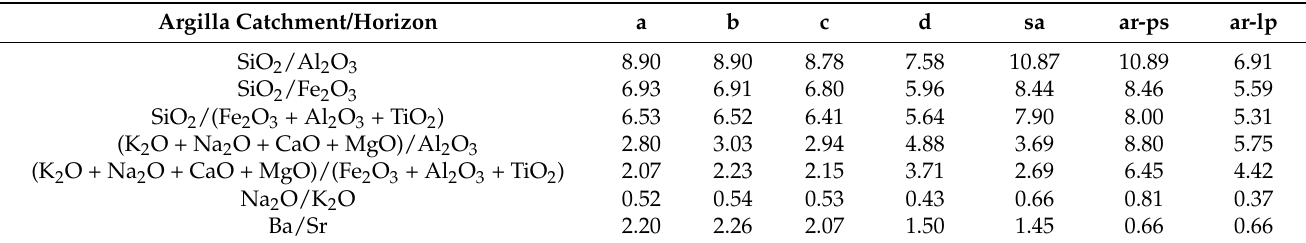
Table 1. Mean weathering index values in soil profiles (a, b, c, and d horizons), stream sediments (sa), and not weathered marls (ar-lp) and sandstones (ar-ps) in the river Argilla catchment. Argilla